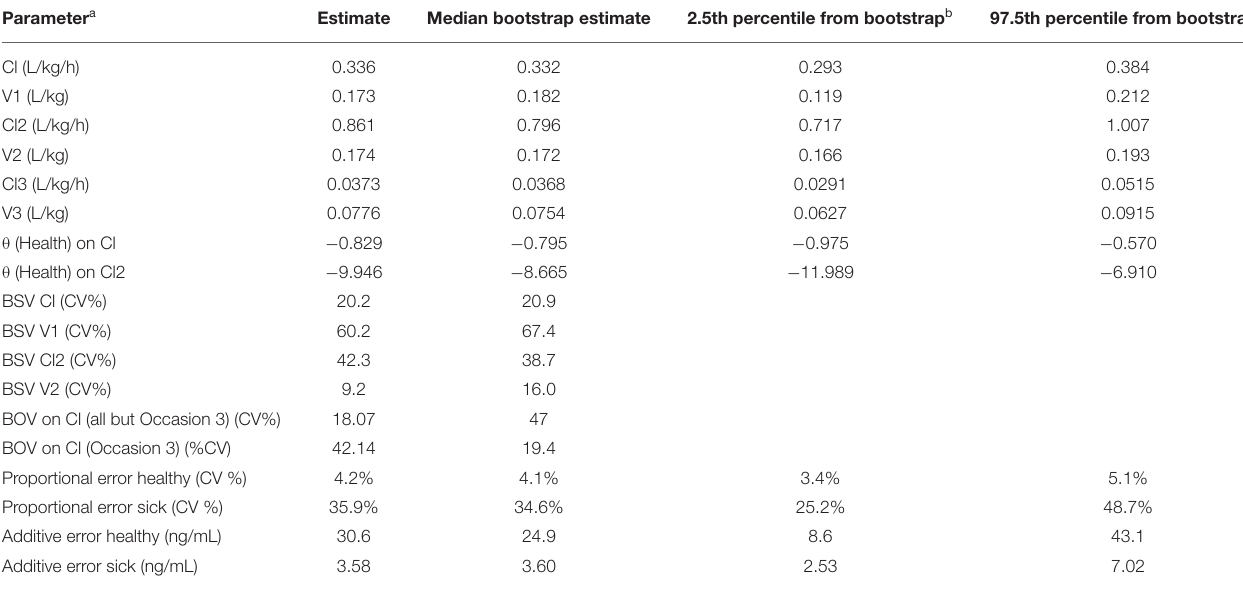
TABLE 4 | Population pharmacokinetic estimates of amoxicillin in healthy and sick dogs. Parameter